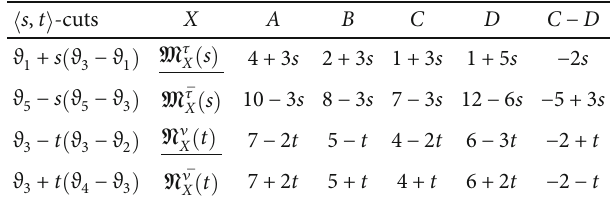
Figure 5: The graph of the solution obtained in Example 2. Table 1: h s , t i -cuts of A , B , C , D , and X